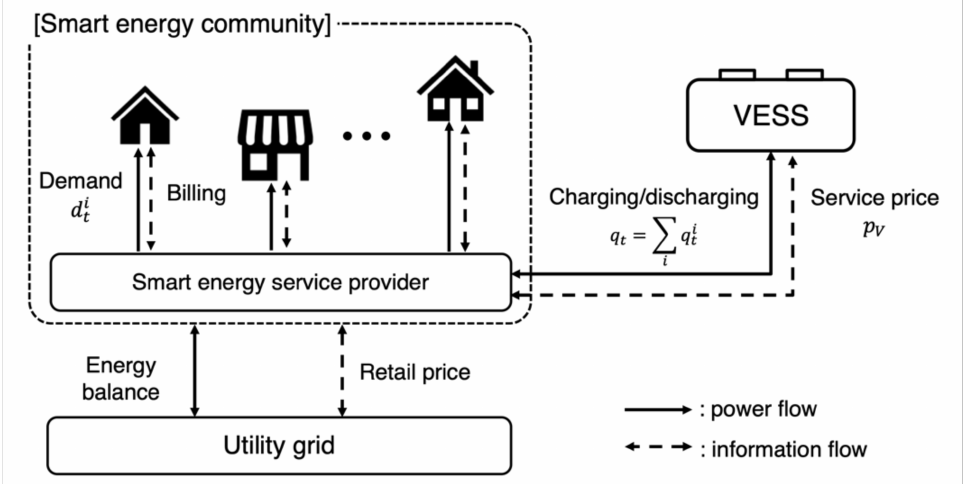
Figure 1. Constitution of a virtual energy storage system (VESS) for smart energy community